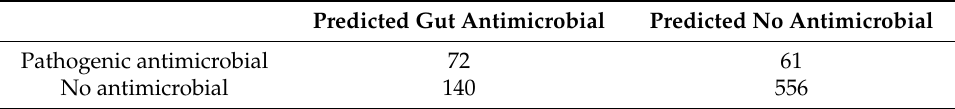
Table 3. Confusion matrix for the discovery set.